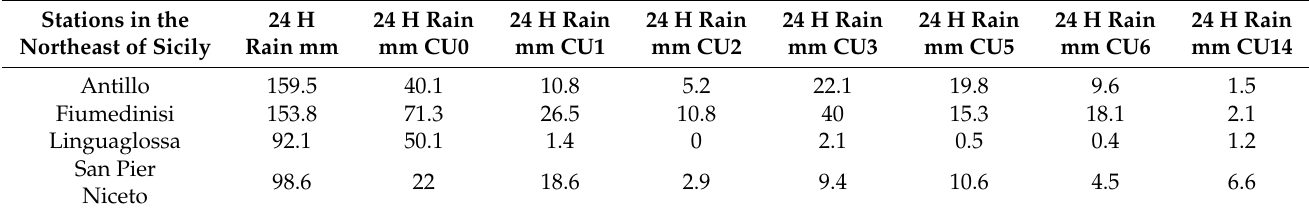
Table 2. The forecasted rainfall data and observed data provided by the 5 stations in the northeast of Sicily. Stations in the